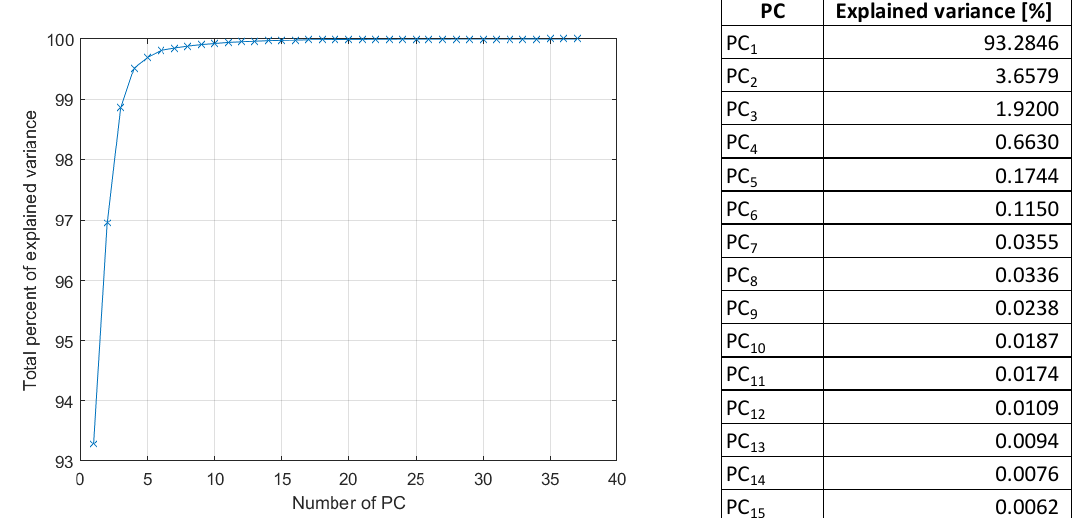
Figure 6. The variance explained by principal components.